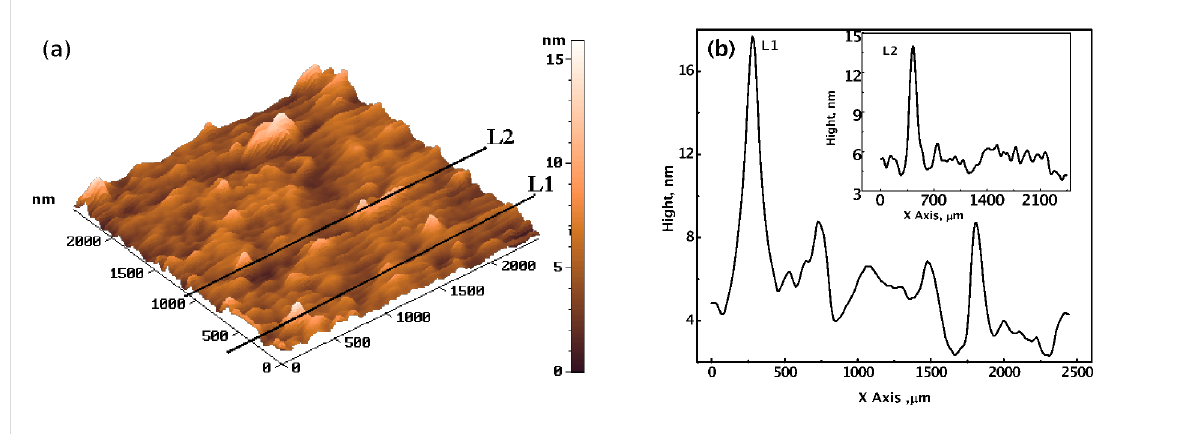
Figure 10: AFM image of the CdSe quantum dots, synthesized by the reaction of 2.0 × 10 − 3 mol dm − 3 Cd(AcO) 2 with 1.0 × 10 − 3 mol dm − 3 Na 2 SeSO 3 , in the presence of 9.2% PVA, at 27 °C, (a) 3D image, and (b) height profiles of lines L1 and L2.